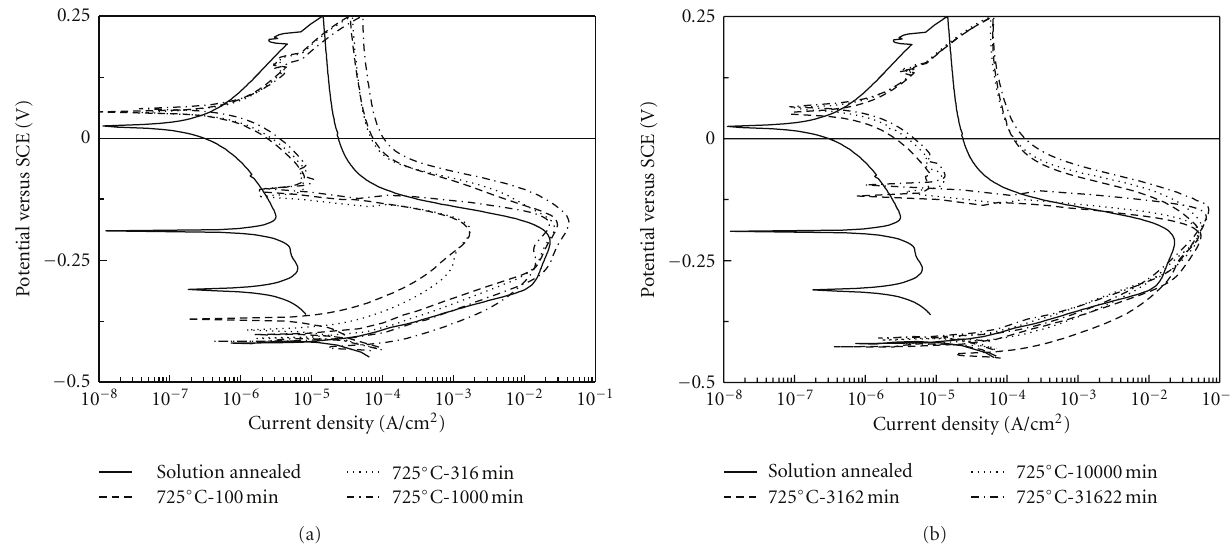
Figure 7: DLEPR curves plotted for DSS after solution and sensitization heat treatments at 725 ◦ C between 100 and 31622 min (scan rate: 15V/hr).